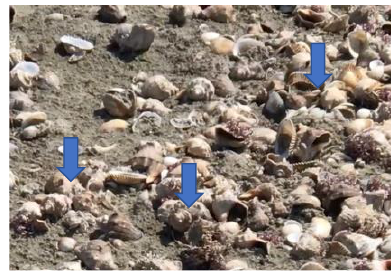
Figure 1. R. venosa egg capsules waste.